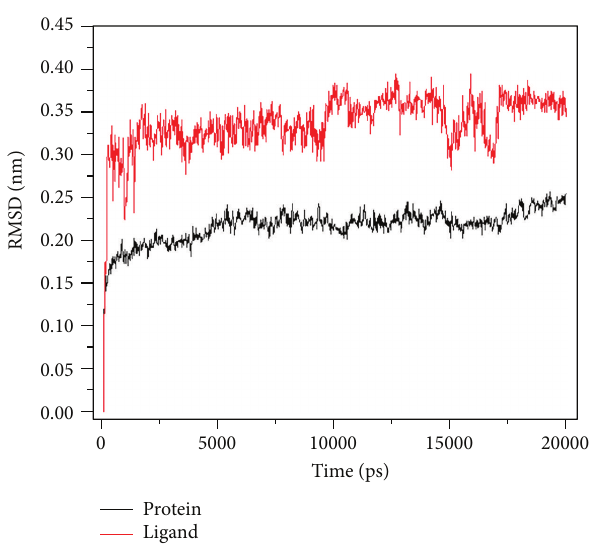
Figure 4: Plot of the temporal RMSD of compound 2 inside AChE.